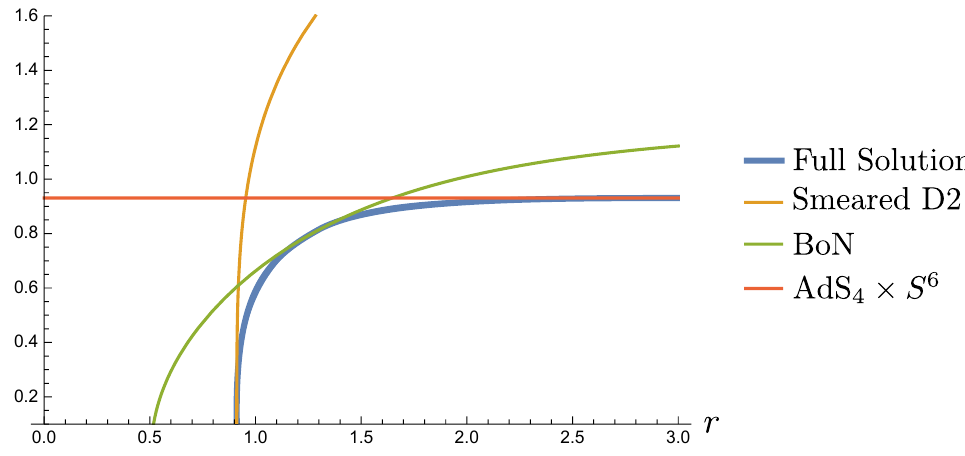
φ 4 controlling the size of S